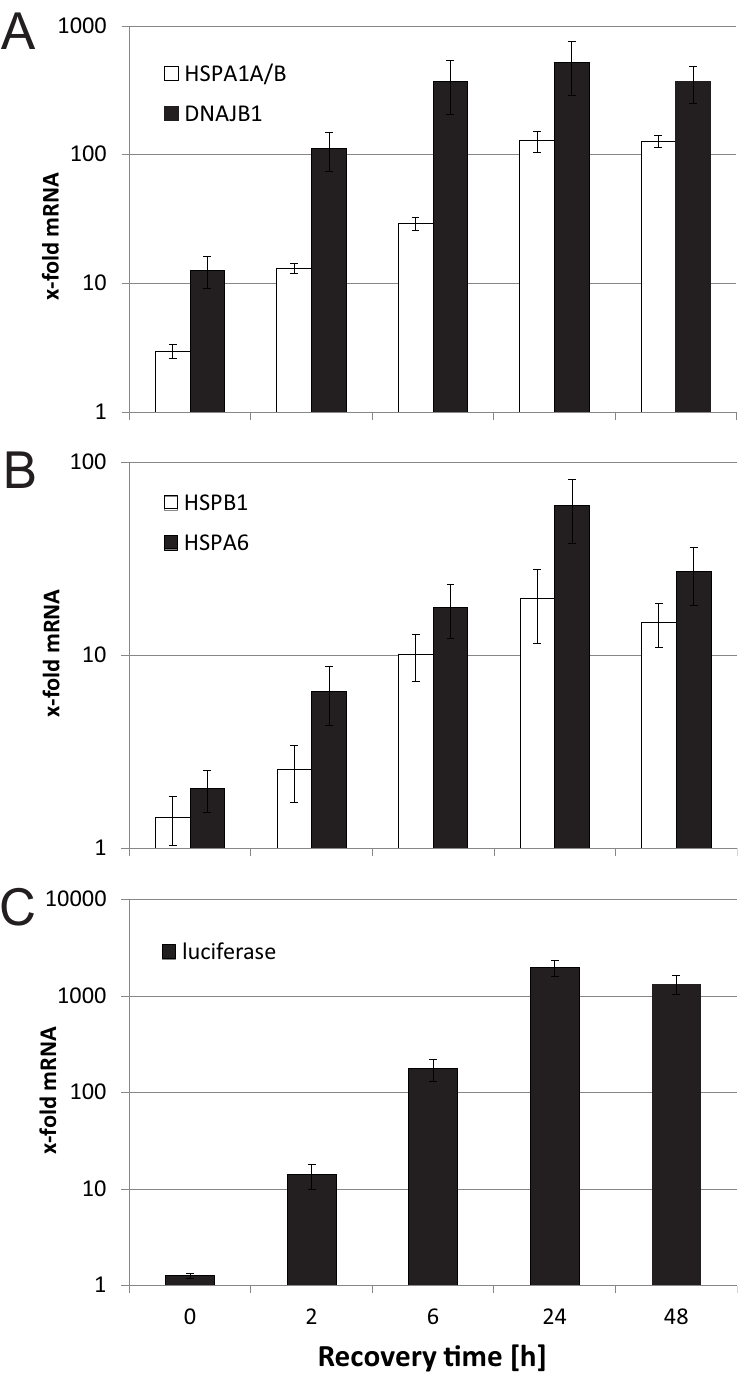
Fig 2. HSF1 target gene expression on mRNA level. C5 cells were treated with 250 μ M CdSO 4 for 1 h, then washed once, and afterwards recovered for different time periods (2 h, 6 h, 24 h and 48 h), before mRNA harvest. Quantitative PCR was performed for HSPA1A/1B and DNAJB1 (A), HSPB1 and HSPA6 (B) and firefly luciferase (C). GAPDH was used for normalization. Y-axis shows x-fold mRNA levels compared to untreated control cells. All values show means of at least three independent experiments. Error bars indicate